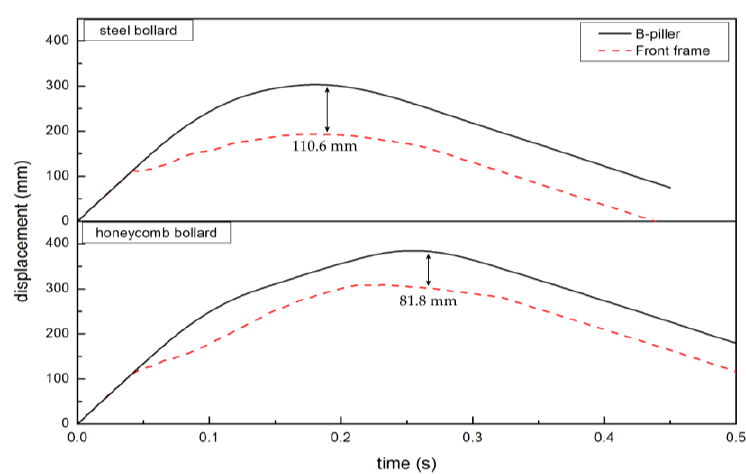
Figure 10. Simulated displacements of steel and in-plane honeycomb bollards.